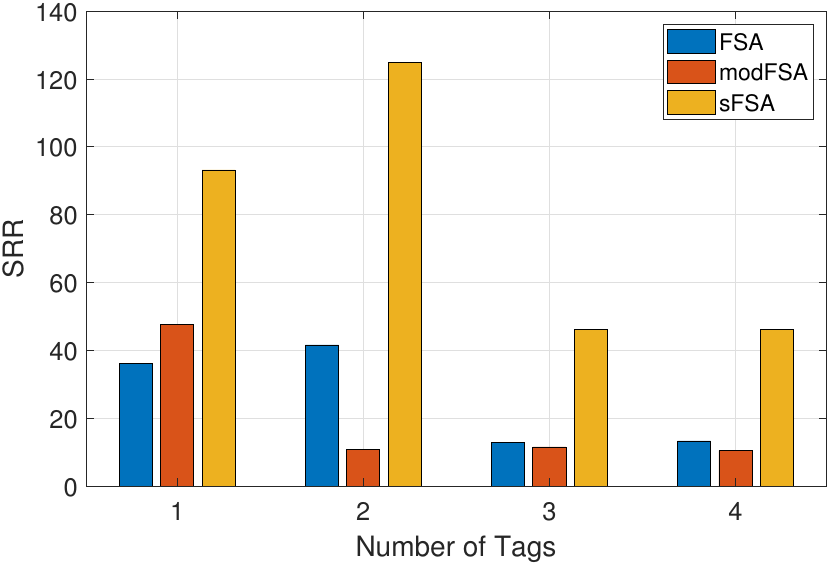
Figure 10. Comparison of SRR for the Framed Slotted Aloha (FSA), the modified FSA and the sFSA protocols for N = 1, 2, 3 tags and S = 5 reads per tag.